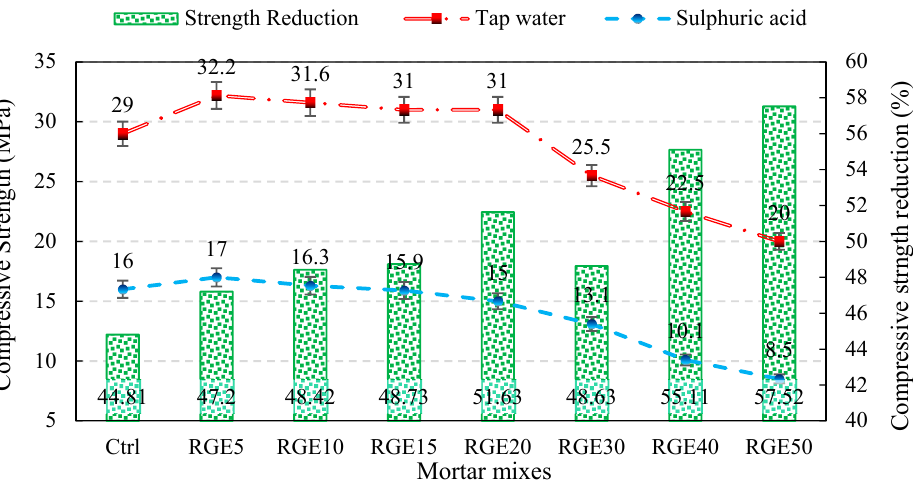
Figure 18. Compressive strength of concrete cubes after 7 days’ immersion in 25% sulphuric acid solution relative to normal curing specimens.